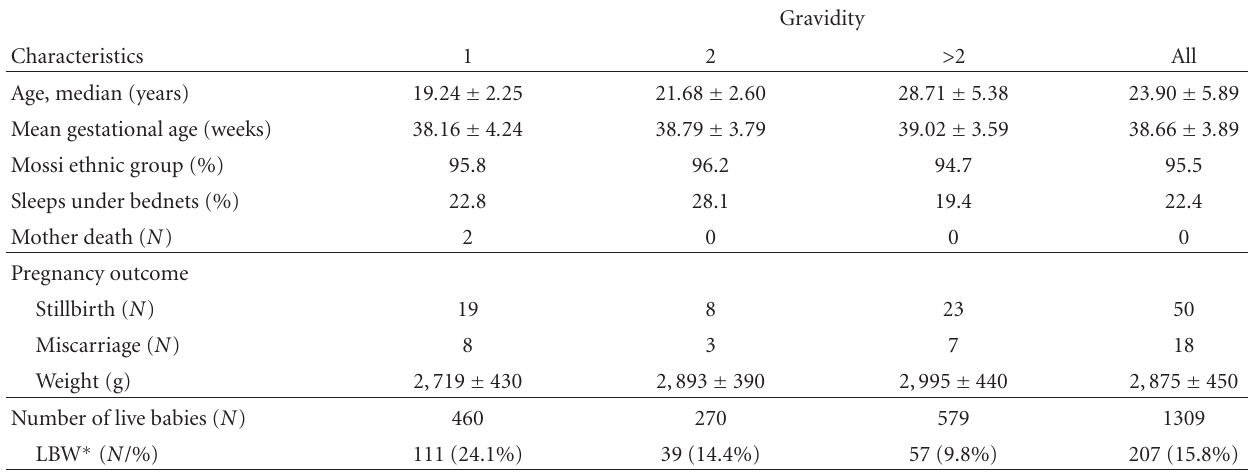
Table 1: Characteristics of enrolled women.